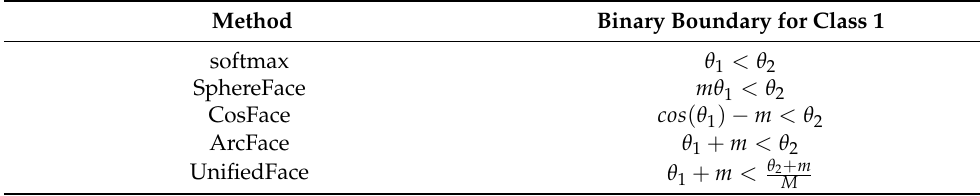
Table 3. Comparison of binary bounds for different loss functions.